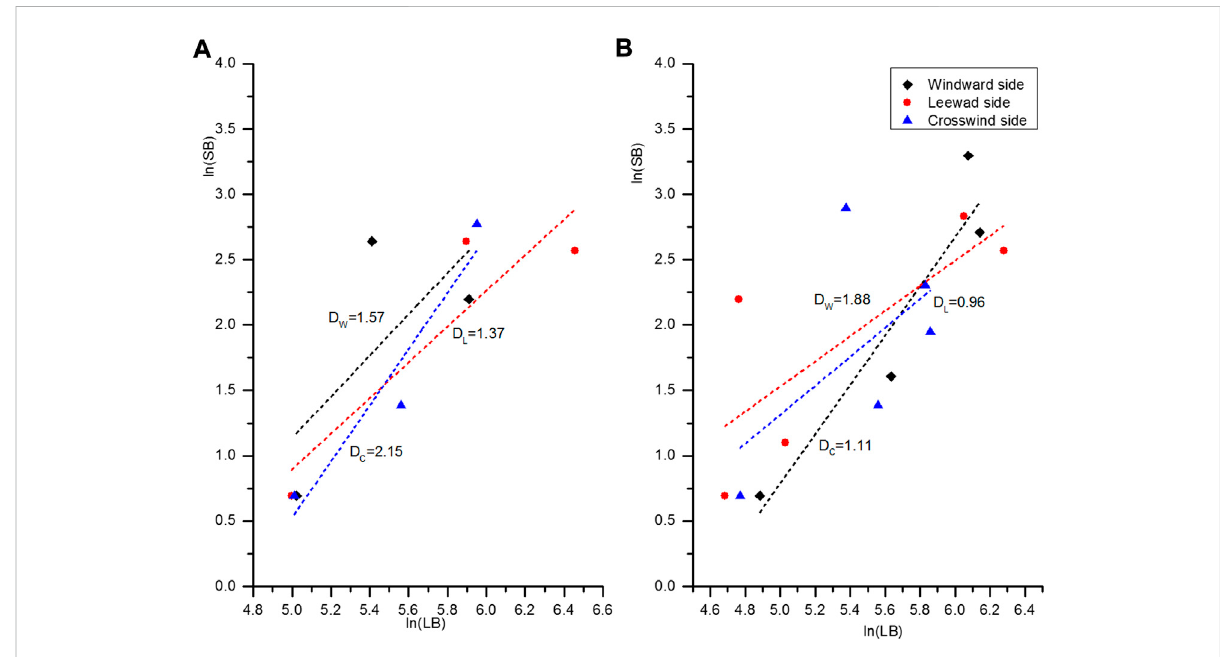
FIGURE 2 Linear fi tting of the fractal dimension of branching of Artemisia ordosica in sandy land [ (A) Semi- fi xed sandy land; (B) Fixed sandy